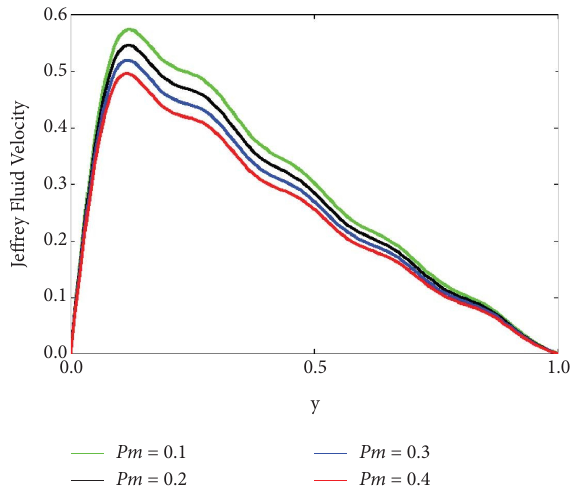
Figure 12: Te impact of diferent values of Re on ψ ( y,t ) .